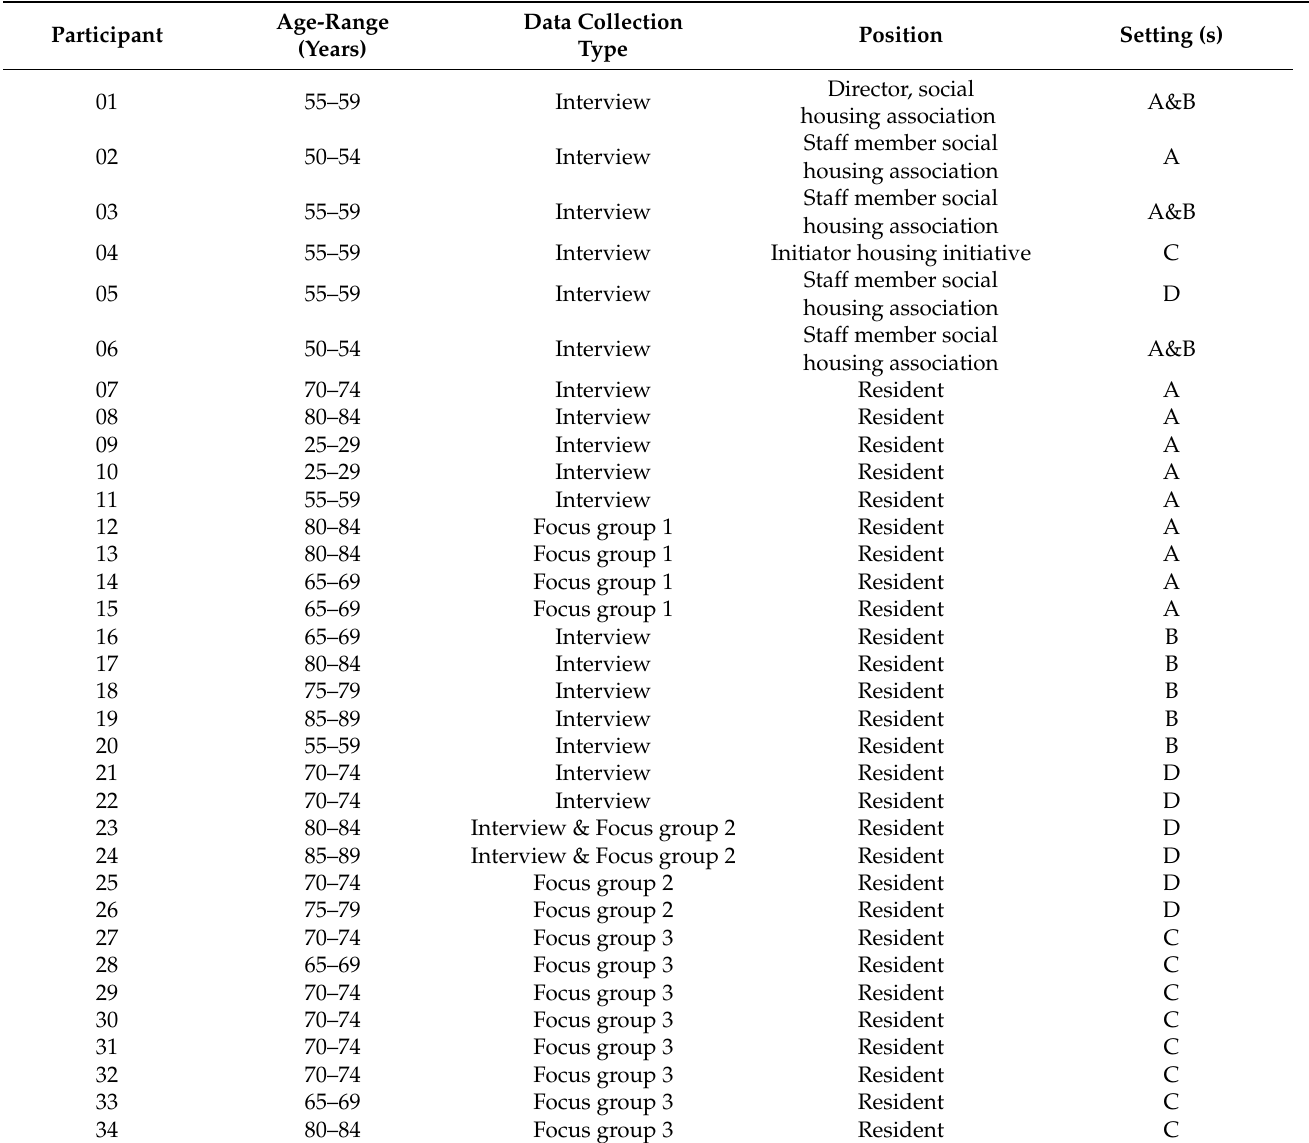
Table 1. Overview of the